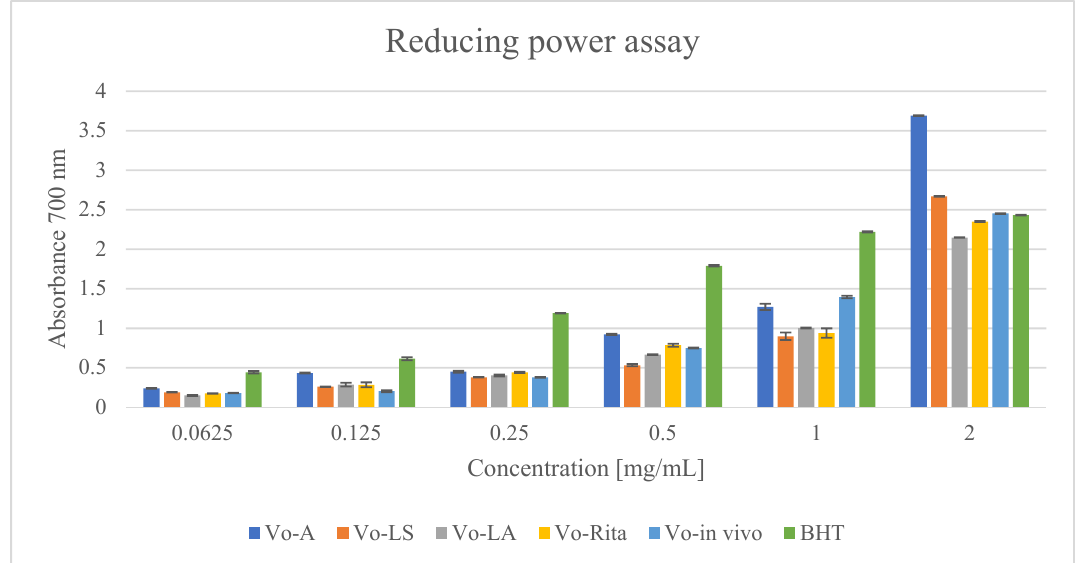
Figure 4. Reducing power of extracts of V. officinalis in vitro cultures; agar (Vo-A), stationary liquid (Vo-LS), agitated (Vo-LA) and bioreactor cultures (Vo-RITA) and of plant material (Vo-in vivo). Values are expressed as mean ± SD (n = 3).